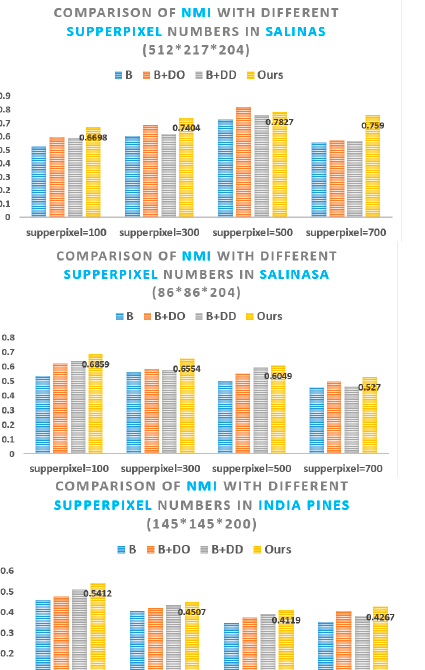
Figure 3. Classification results with different superpixels.